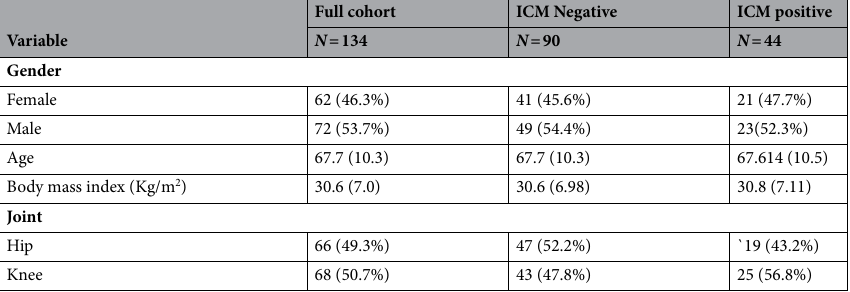
Table 1. Baseline characteristics of the cohort. ICM: International Consensus meeting definition for periprosthetic joint infection. For gender and joint variables, absolute number of subjects and rate as % was reported. For all other variables mean and standard deviation were reported.